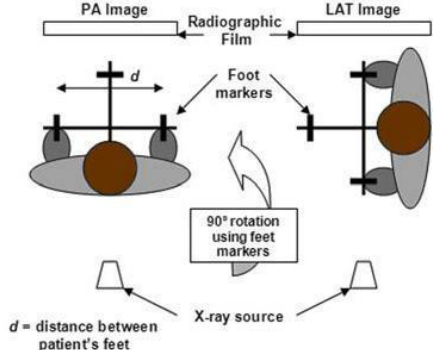
Figure 9. Positioning of the patient; Source: (Kadoury et al.,